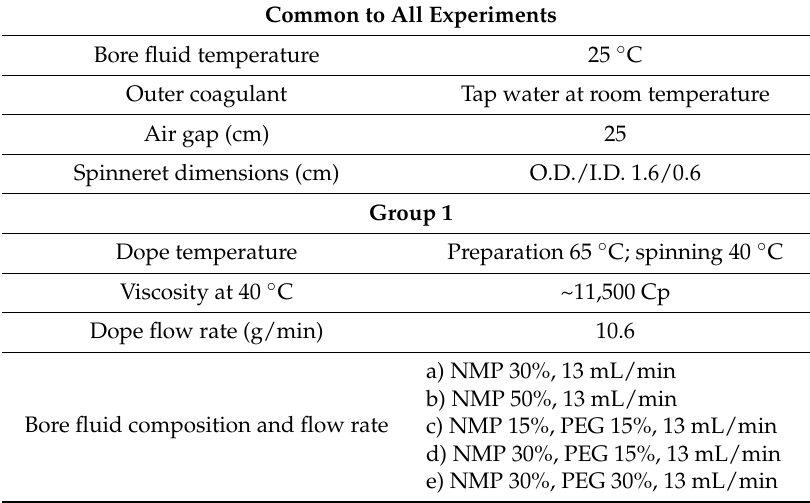
Table 4. Detailed conditions of the spinning experiments. Outer diameter (O.D.)/Inner diameter